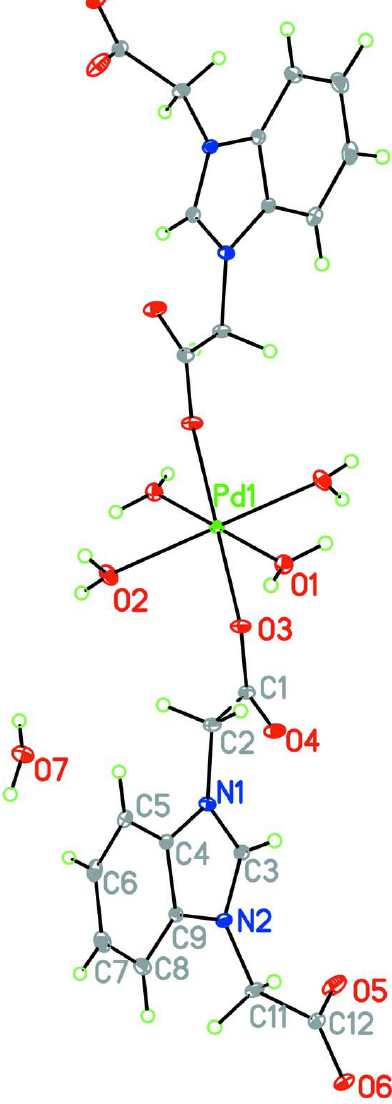
Figure 1 The molecular structure of (I), showing the atomic numbering scheme and 30% probability displacement ellipsoids. [Symmetry code for unlabelled atoms: 1-x, 2-y,